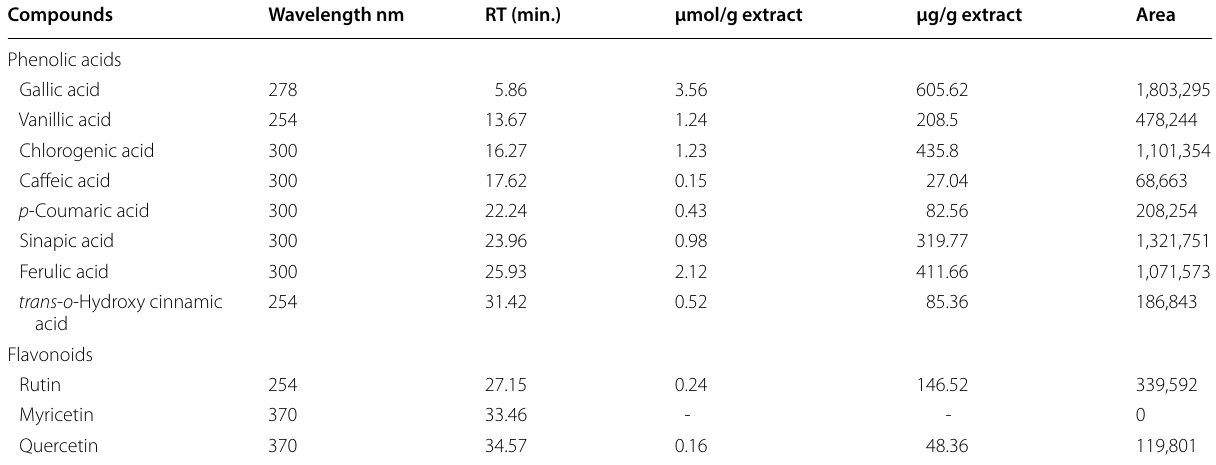
Table 2 HPLC results of selected phenolics and flavonoids of Linum usitatissimum seeds extract Compounds Wavelength nm RT (min.)